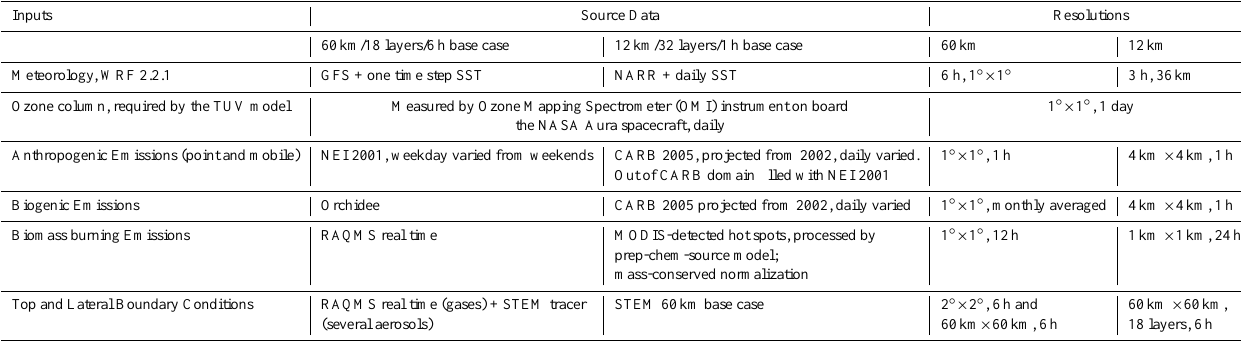
Table 1. Summary of STEM model inputs for base cases in two resolutions.